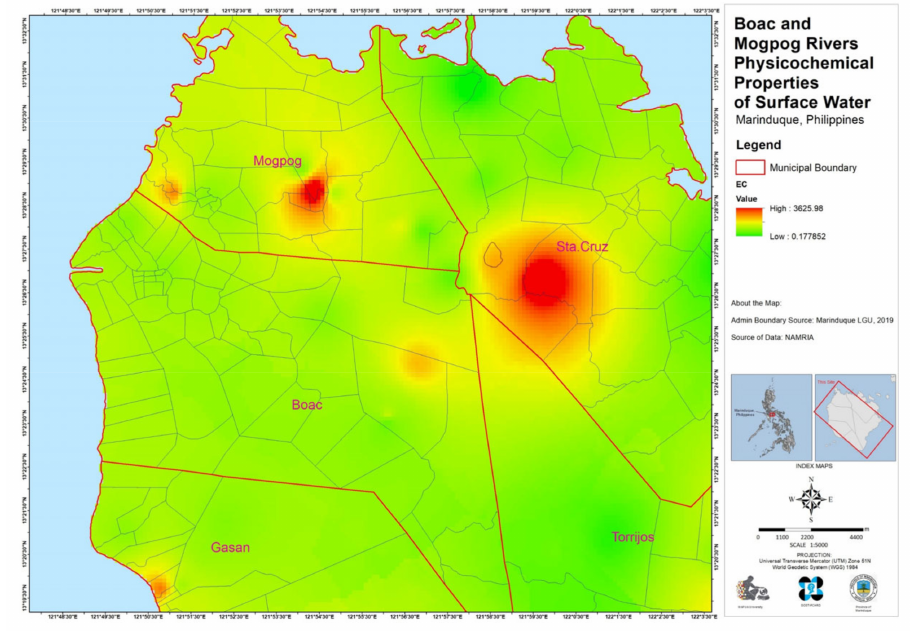
Figure A4. Spatial map for EC.